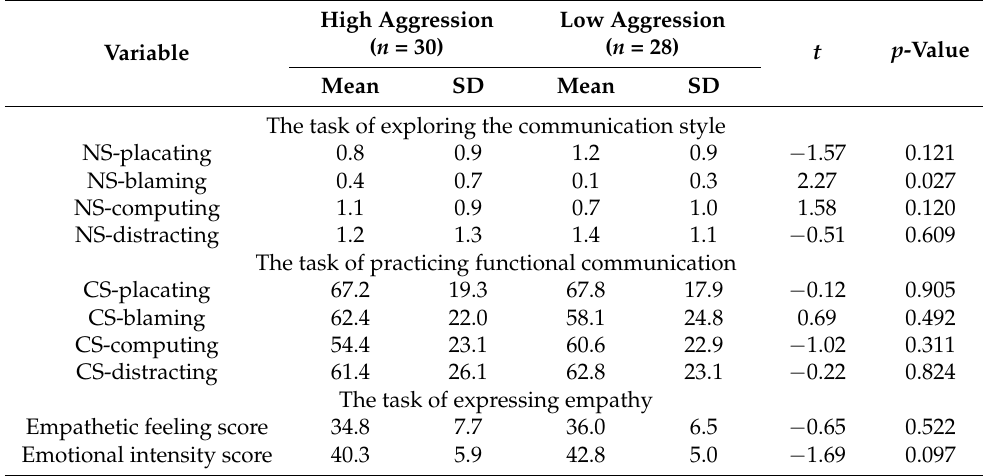
Table 2. Mean and standard deviation (SD) of the behavioral parameters in participants with high aggression and low